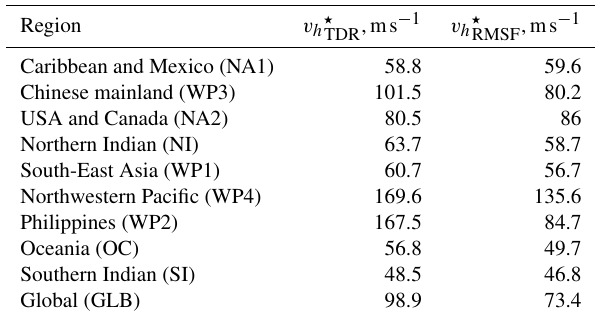
Coefficient from version 1.5 of the CLIMADA environment. Figure A4 also illustrates the shapes of the functions for the different optimization problems (RMSF vs. TDR) and version (1.0 vs.